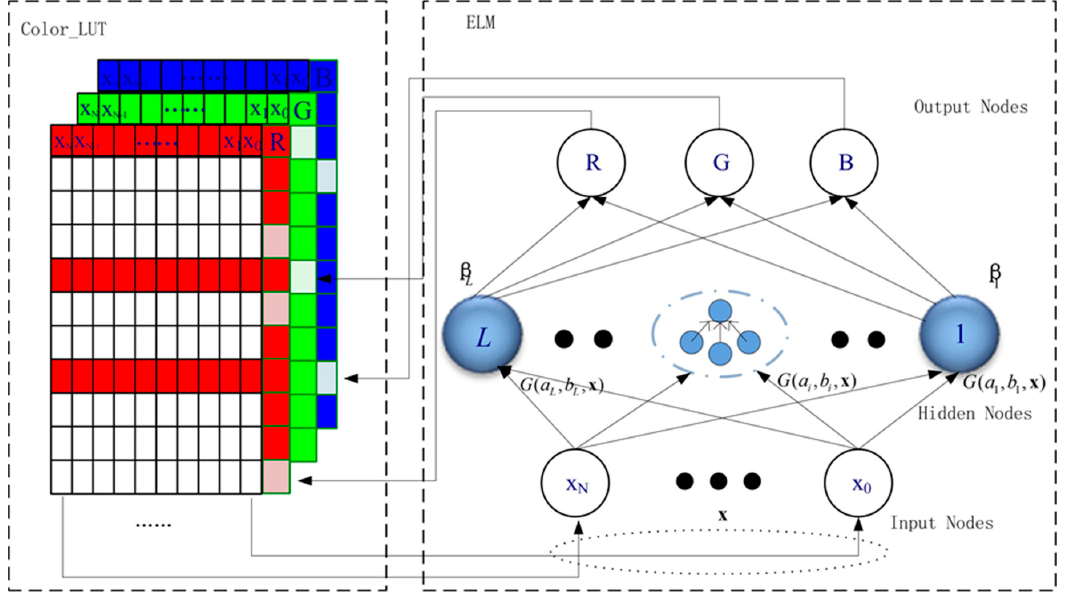
Figure 2. The scheme of estimating nonexistent values based extreme learning machine (ELM).